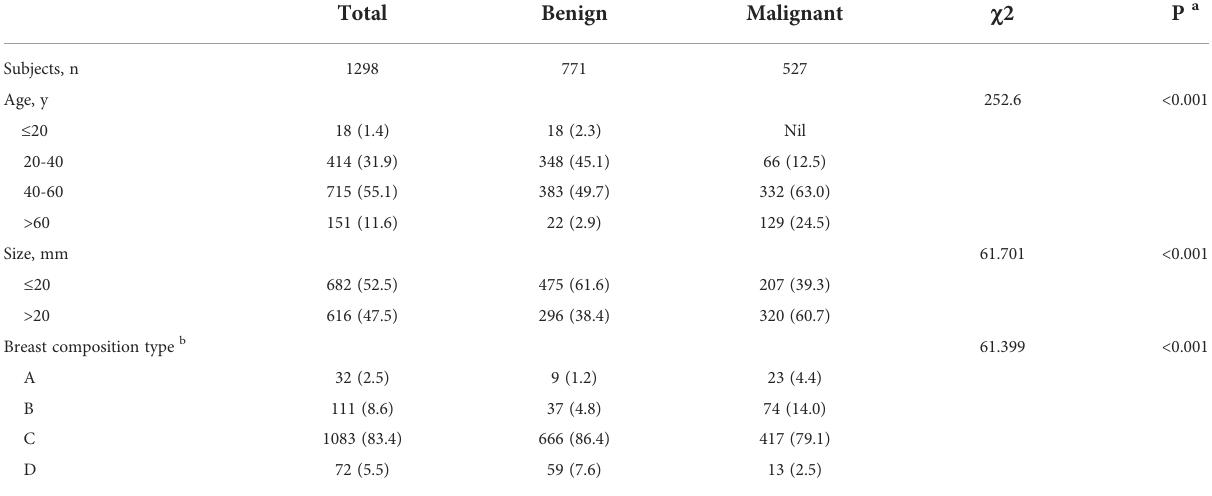
TABLE 1 Clinical characteristics between benign and malignant NSNCM, n